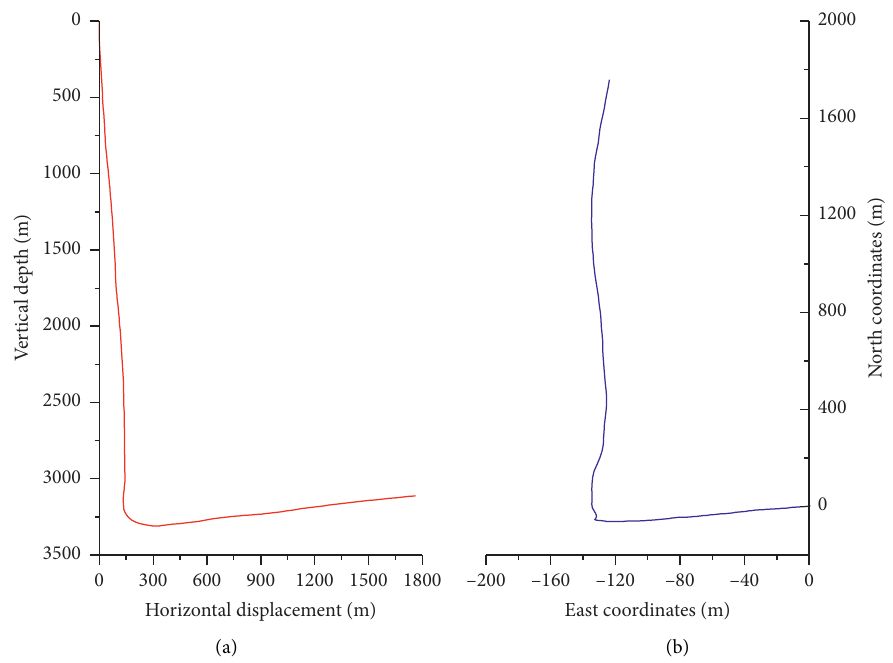
Figure 7: Horizontal well trajectory. (a) Vertical projection view. (b) Horizontal projection view.